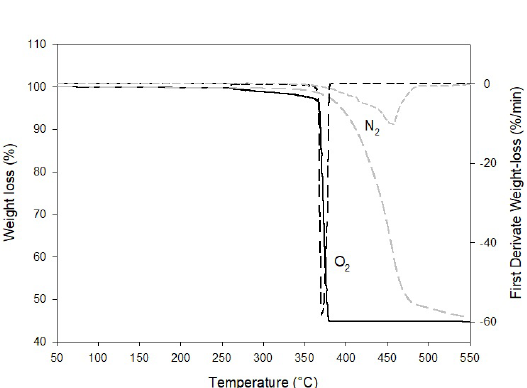
Figure 1. Thermogravimetry and Differential Thermogravimetry analysis (TGA and DTGA, respectively) results for